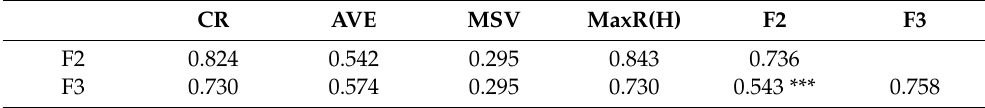
Table 3. Correlation matrix of validity of tourist services quality model.